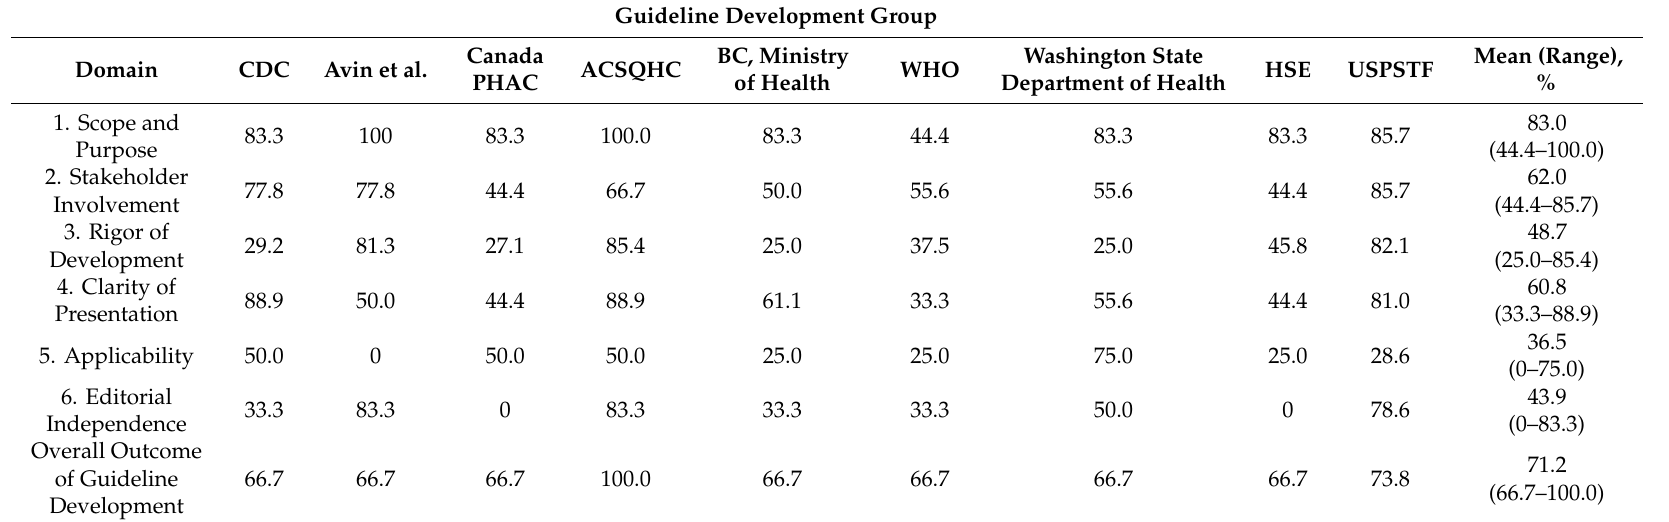
Table 2. Results of the Appraisal of Guidelines for Research and Evaluation II (AGREE II) evaluation. Guideline Development